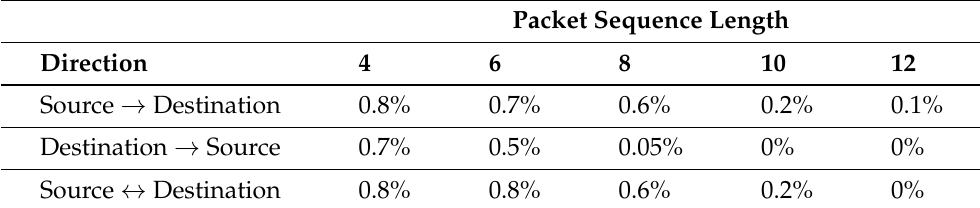
Table 7. Resulting false discovery rate (FDR) of different types of signatures against part of the benign traffic. Signatures are part of the attack samples from the “Exploits” category. The signatures are generated after a combination of packet direction and packet payload size.